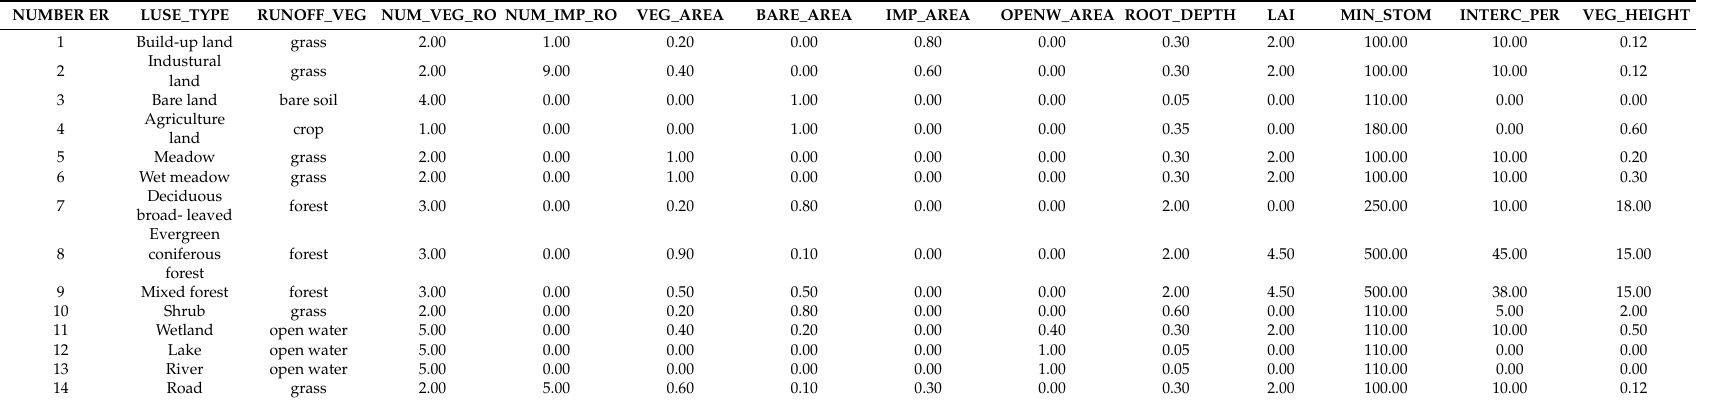
Table A1. WetSpass land use parameter.